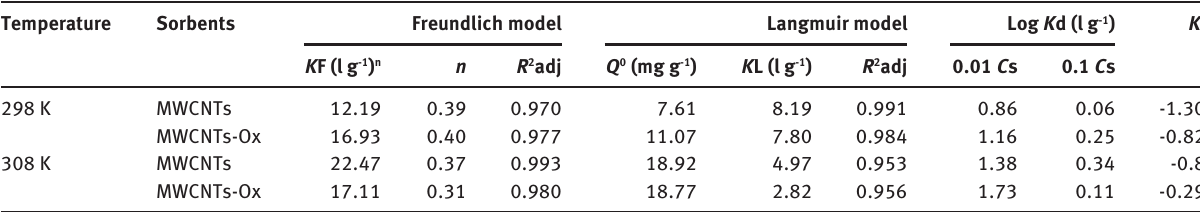
Table 2: Fitting parameters for methylene blue dye adsorption on multi-walled carbon nanotubes (MWCNTs) and oxidized MWCNTs (MWCNTs-Ox) at two different temperatures. Temperature Sorbents Freundlich model